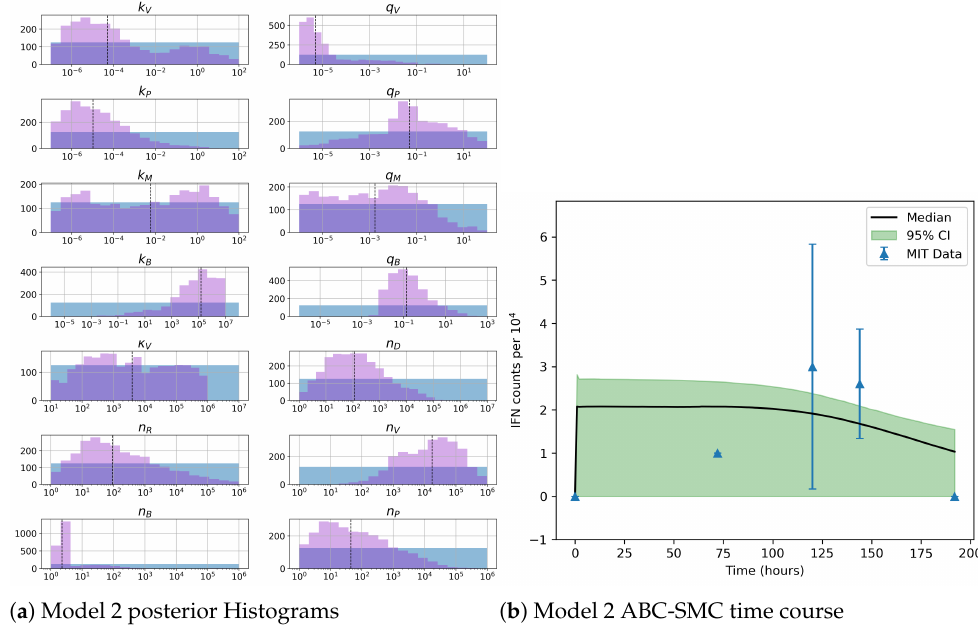
Figure 9. ( a ) Posterior histograms obtained from the ABC-SMC algorithm. Blue histograms indicate prior distributions and purple histograms illustrate posterior ones. ( b ) Model fit from accepted parameter sets obtained during the final iteration of the ABC-SMC algorithm. Blue triangles represent data presented in Table 1 plotted with its standard deviation. The black line illustrates the point-wise median value from the accepted parameter sets (shaded in green) with a 95% credible interval. These results represent 18 iterations with 2500 accepted parameter sets for model